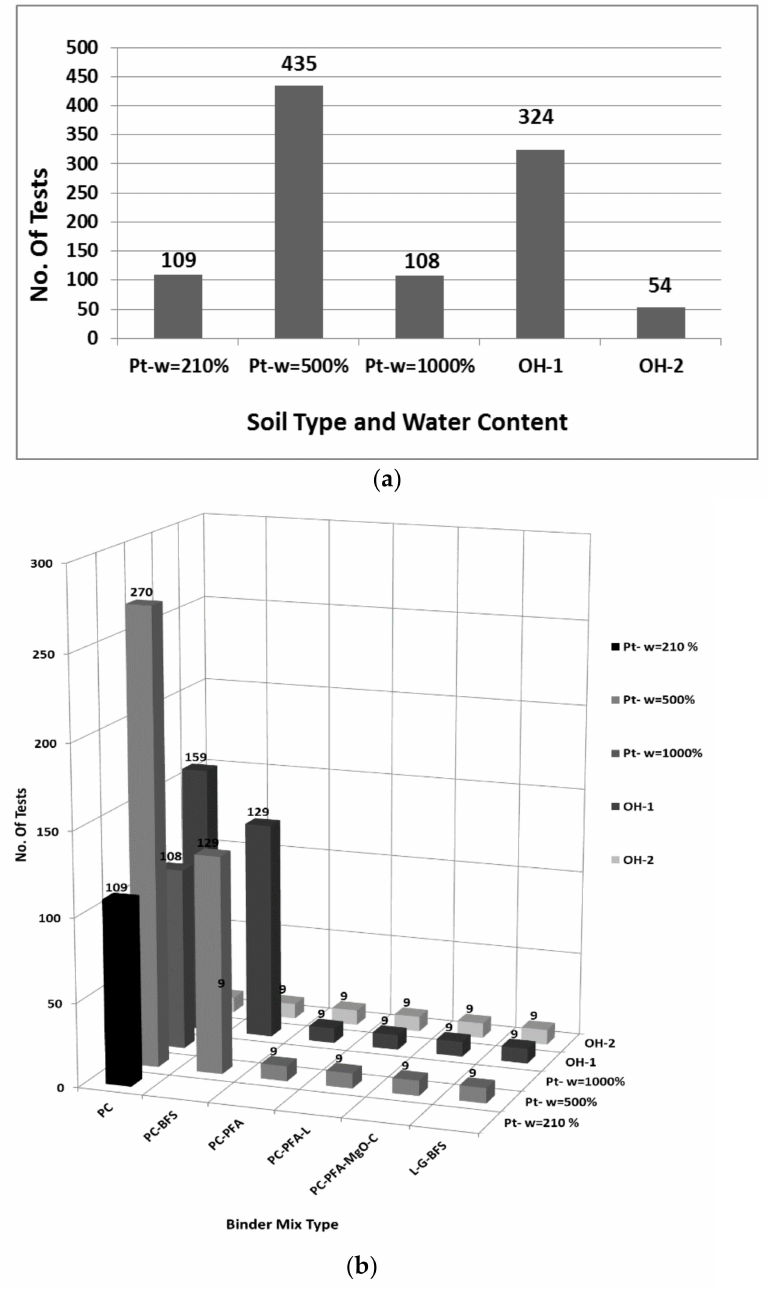
Figure 7. Histograms of ( a ) number of tests of soils and soil–binder combinations, and of ( b ) soils and soil–binder combinations in terms of binder mix type content (RB- PC , RB-GGBS, RB-PFA, RB-L, RB-MgO and